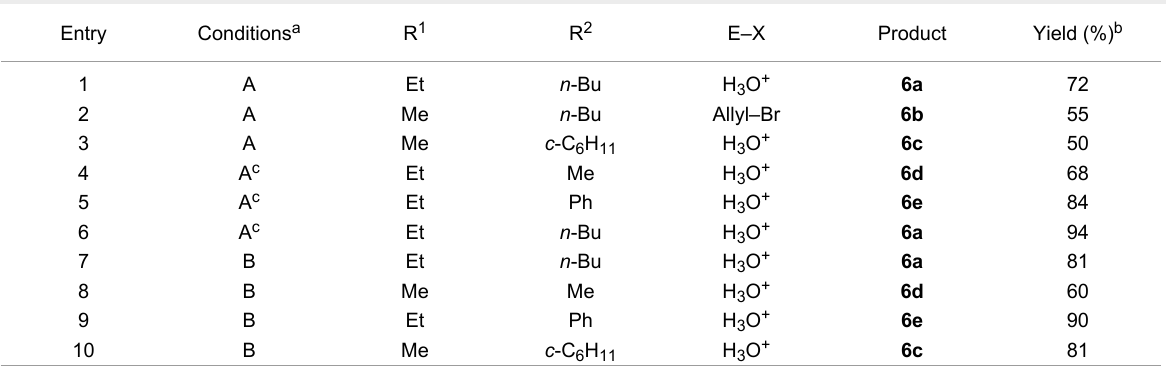
Table 2: Carbometallation reactions of alkynylcarbamates 4